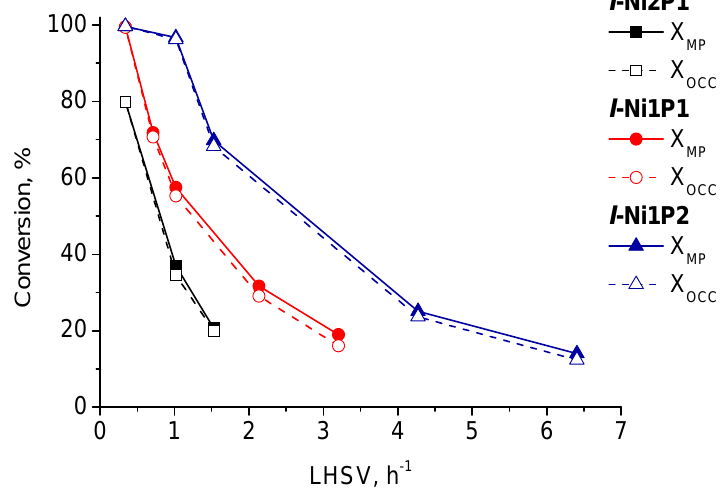
Figure 9. Methyl palmitate (X MP ) and oxygen (X OCC ) conversions versus liquid hourly space velocity (LHSV) of MP (h − 1 ) over the low-loaded nickel phosphide catalysts with different Ni/P molar ratios: l -Ni2P1, l -Ni1P1 and l -Ni1P2. Reaction conditions: P H2 = 3.0 MPa, T = 290 ◦ C, H 2 /feed = 600 Nm 3 /Nm 3 , LHSV = 0.3–6.4 h − 1